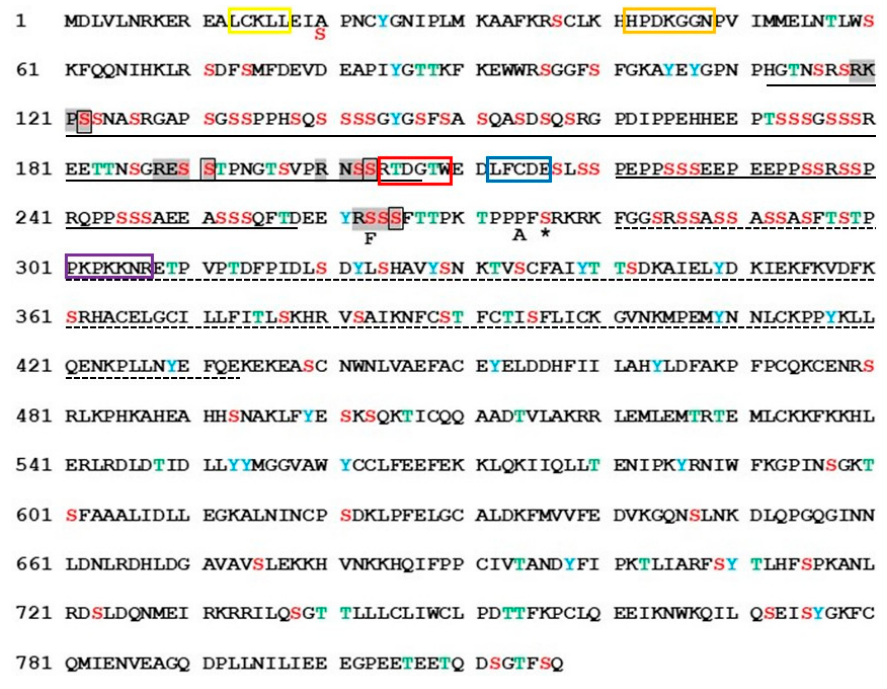
Figure 1. Amino acid sequence of MCPyV full-length large T-antigen (strainR17b; accession number NC_0102777). Putative phosphoacceptor serine (S), threonine (T), and tyrosine (Y) residues are highlighted in red, green, and blue, respectively. The sequence of the truncated large T-antigen variant MKL2 from a MCPyV-positive MCC tumor is identical except for S in position 20, phenylalanine (F) in position 263, alanine (A) in position 274, and stop (*) at residue 276. The PKA consensus motifs (RxxS) are highlighted in grey and the putative phosphoacceptor site is boxed. The functional CR1 domain (yellow), DnaJ domain (orange), hVam6p (red), pRb binding domain (blue), and NLS (purple) are boxed. The MCPyV large T-antigen unique regions MUR1 and MUR are underlined by a full line, and the origin binding domain is underlined by a dashed line. The C-terminal part of large T-antigen encompasses the ATPase/helicase